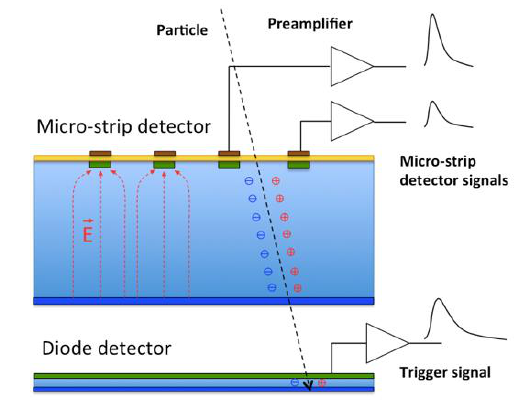
Fig. 3. Sketch of signal formation and the EASY diode trigger.